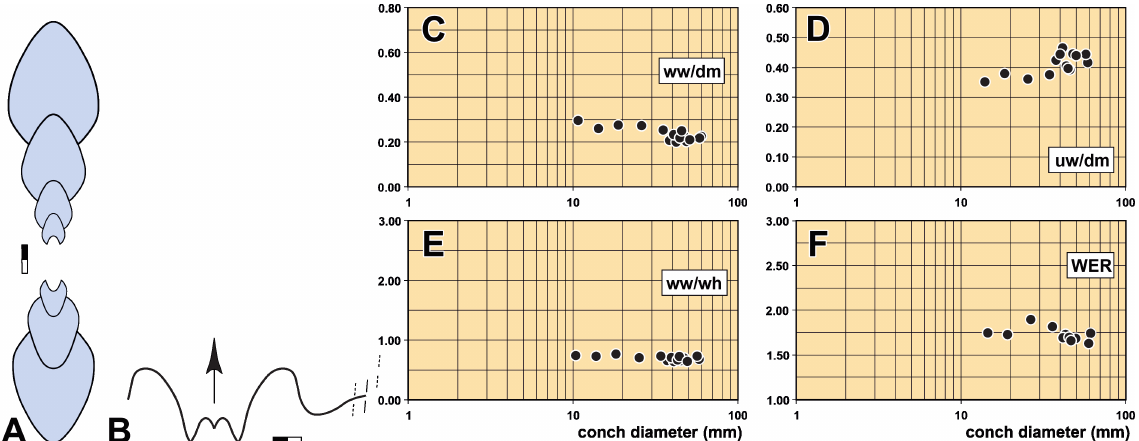
Fig. 9. Ponticeras aequabile (Beyrich, 1837). A . Cross section of specimen MB.C.30419 from the Dillenburg area. B . Suture line of lectotype MB.C.4289.1 (Beyrich 1835 Coll.) from Oberscheld (Sessacker), at dm = 31.5 mm, wh = 10.0 mm. C–F . Ontogenetic trajectories of the cardinal conch parameters. Scale bar units = 1